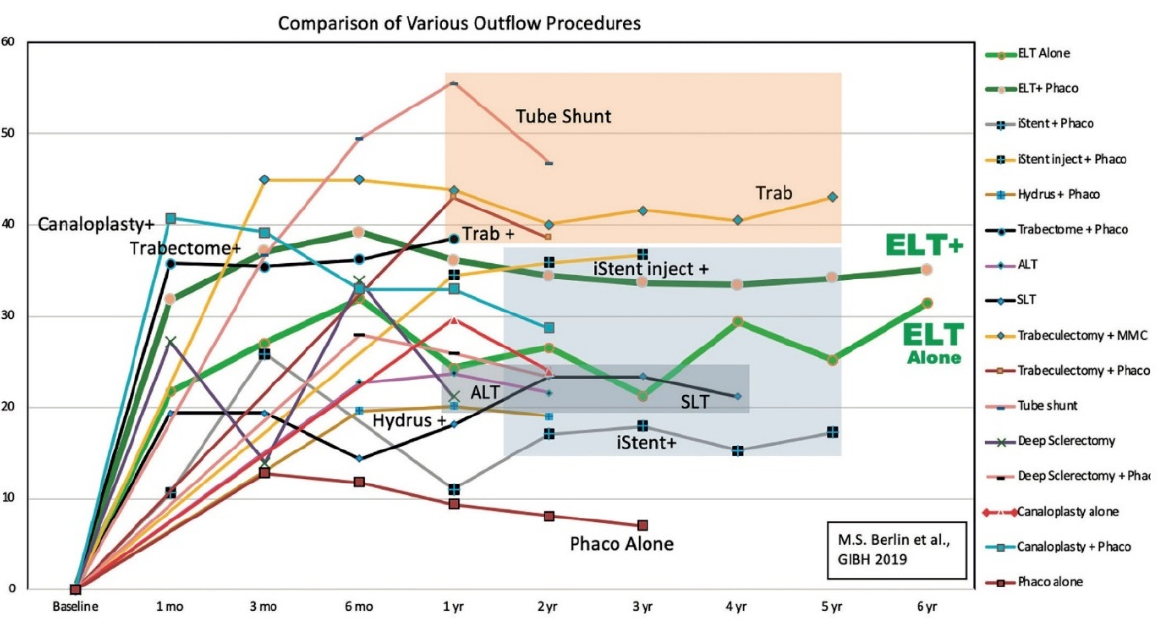
Figure 1. From Berlin et al. (2019): Comparison of various outflow procedures over time based on published results of exemplary studies. The y -axis represents the percentage decrease of IOP from Pre-Op IOP and the x -axis represents the number of years. Reprinted with permission from Ref. [35]. 2019, Kugler Publications.